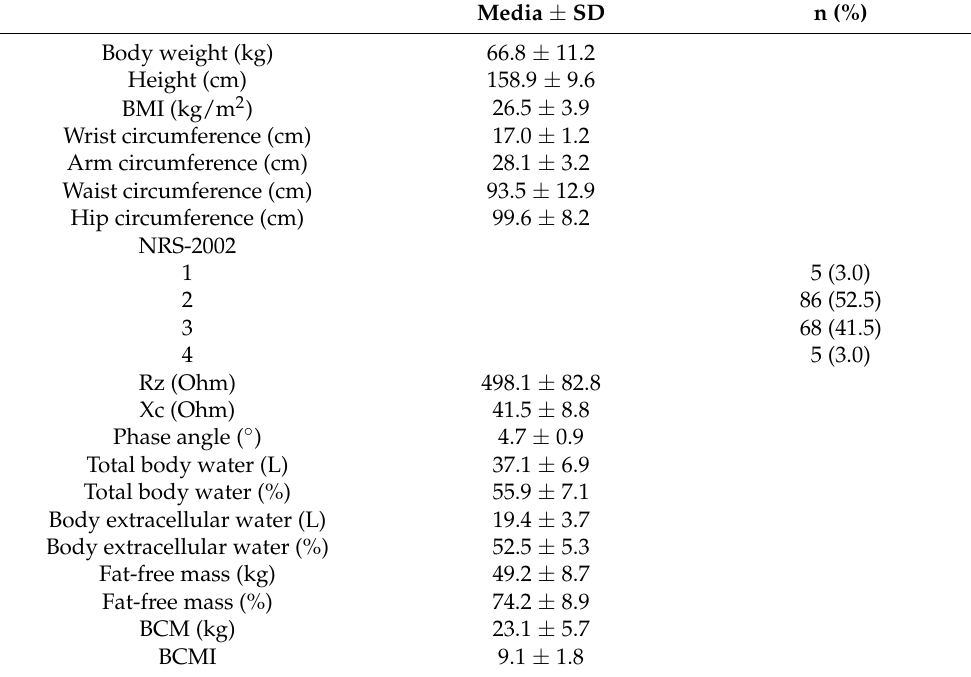
Table 2. Baseline nutritional characteristics of patients following NutriCatt protocol ( n = 166).